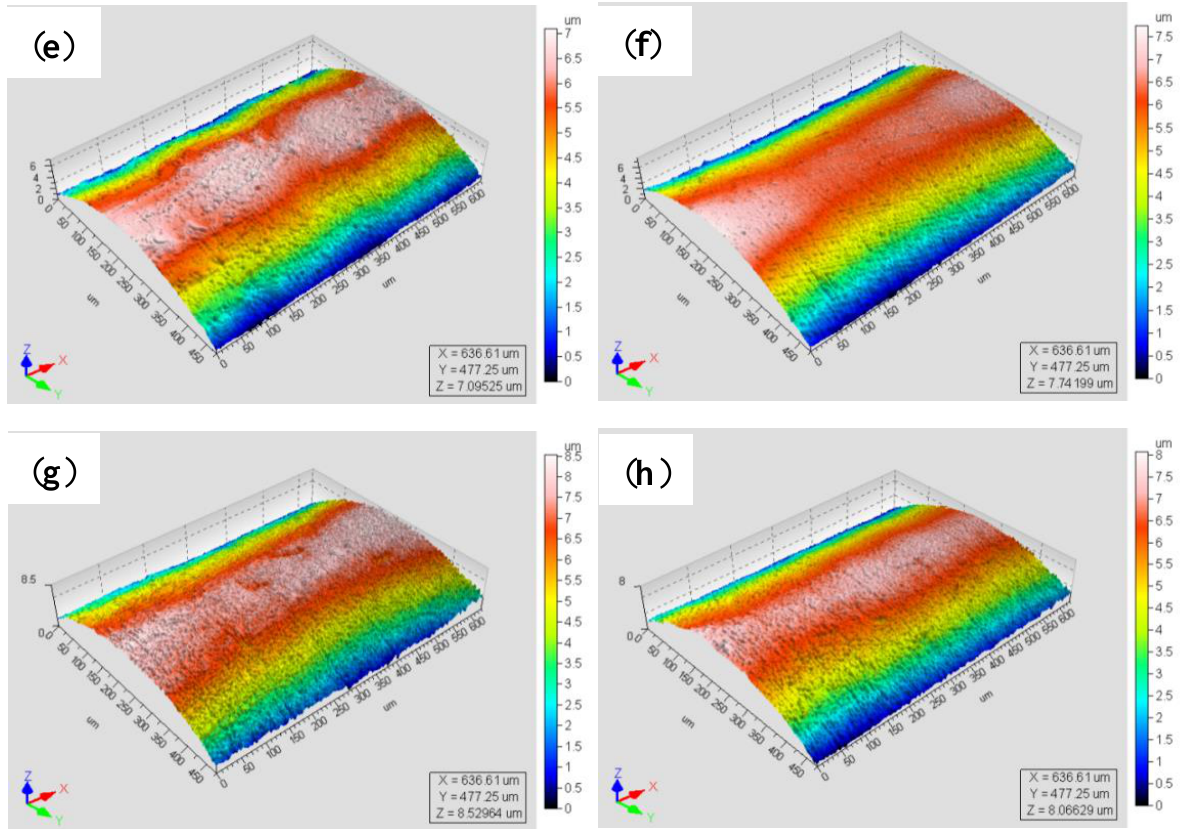
Figure 5. Surface 3D morphologies of different surface ultrasonic rolling processes. ( a ) Original surface 3D morphologies; ( b – h ) the surface 3D morphologies of process SUR-SUR7 samples, respectively.